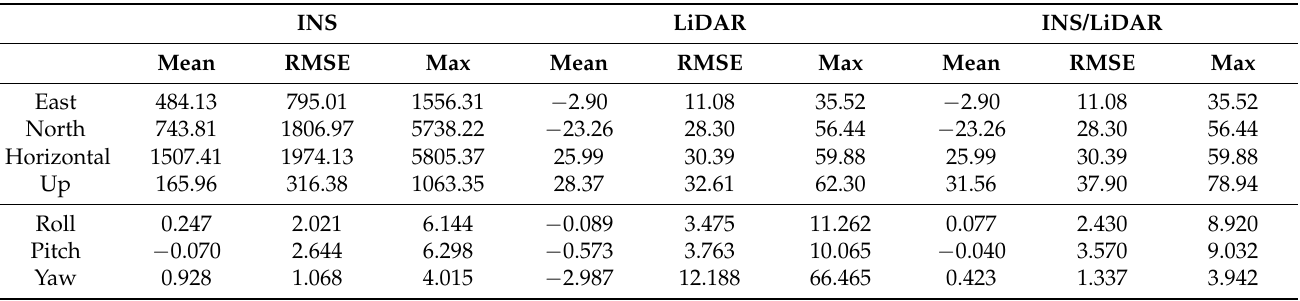
Table A9. D-34_d—position (m) and attitude (deg) error